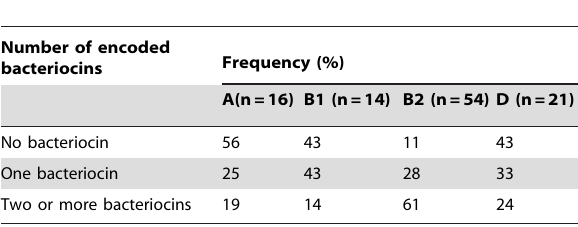
Table 1. Frequency of E. coli strains encoding multiple bacteriocins with respect to phylogenetic group (groups A, B1, B2,